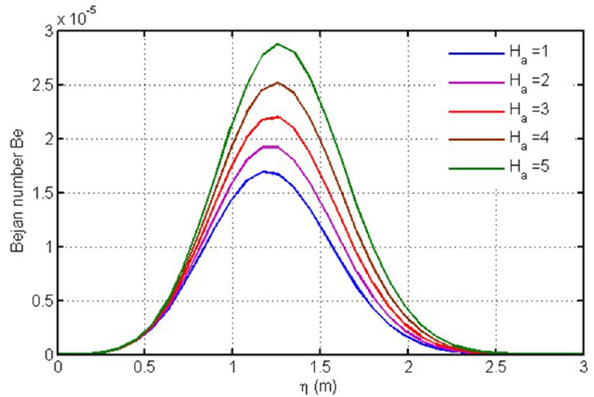
Figure 2. Plot for Bejan number versus η against Ha .